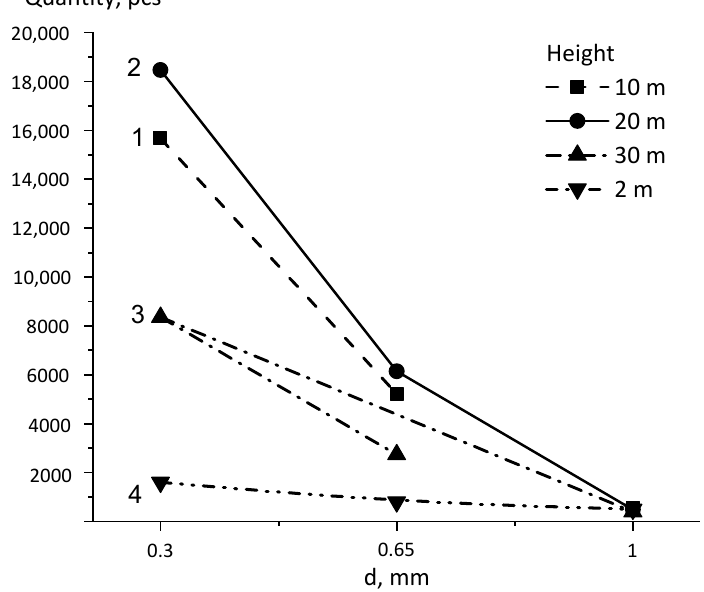
Figure 6. Distribution of aerosol concentration by particle diameter at a distance of 125 m from the combustion source at different heights.